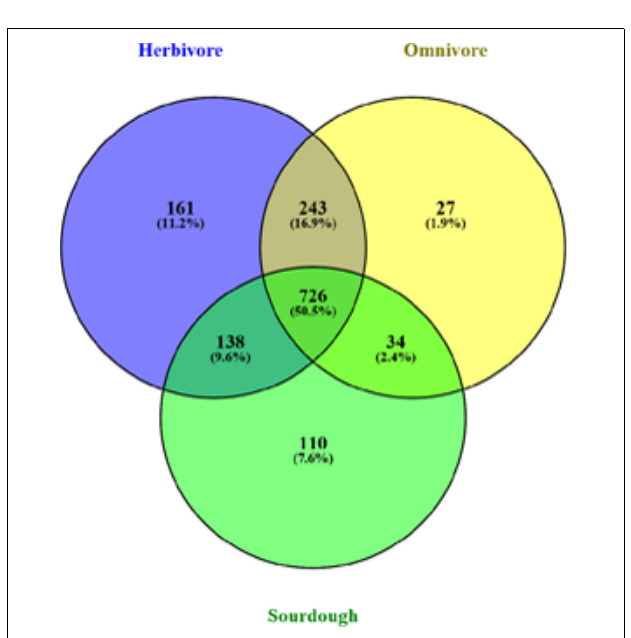
FIGURE 2 | Venn plot showing shared and unique core genes distribution among Lactobacillus reuteri strains in herbivore, omnivore, and sourdough